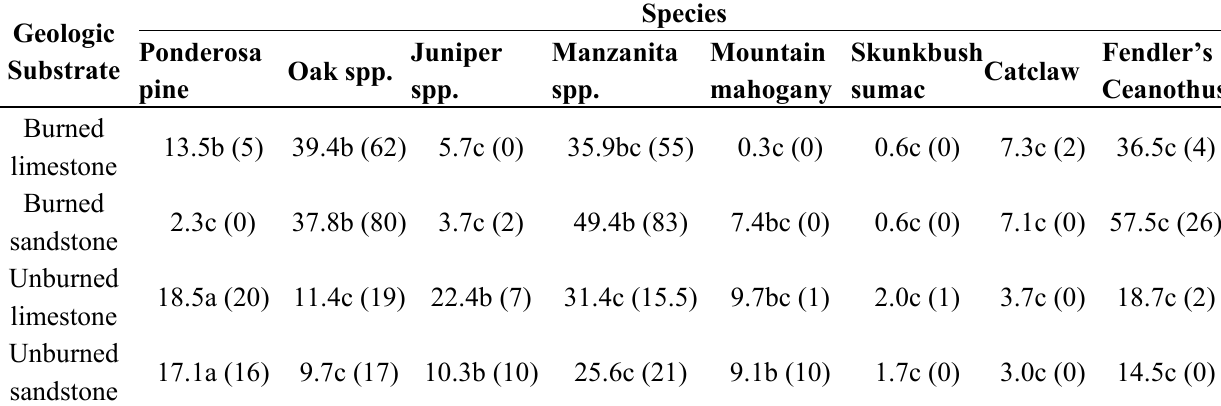
Table 3. Mean number of stems/plot (median number of stems/plot) for woody species across sandstone and limestone parent materials and burned and unburned conditions. Within a column, strata with the same letter are not significantly different according to the Peritz closure multiple comparison procedure, α = 0.10